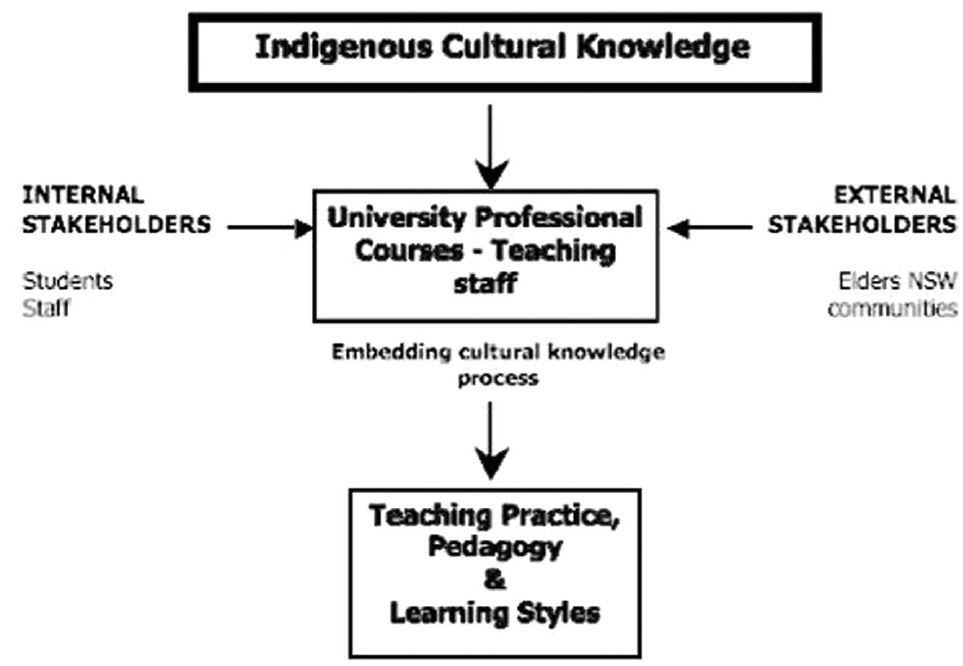
Embedding Aboriginal cultural content through a consultative engagement process.